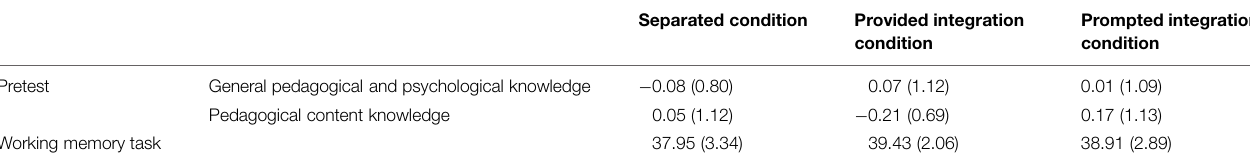
TABLE 4 | Mean (and SD) of the z-standardized pretest and working memory scores in the three experimental groups.